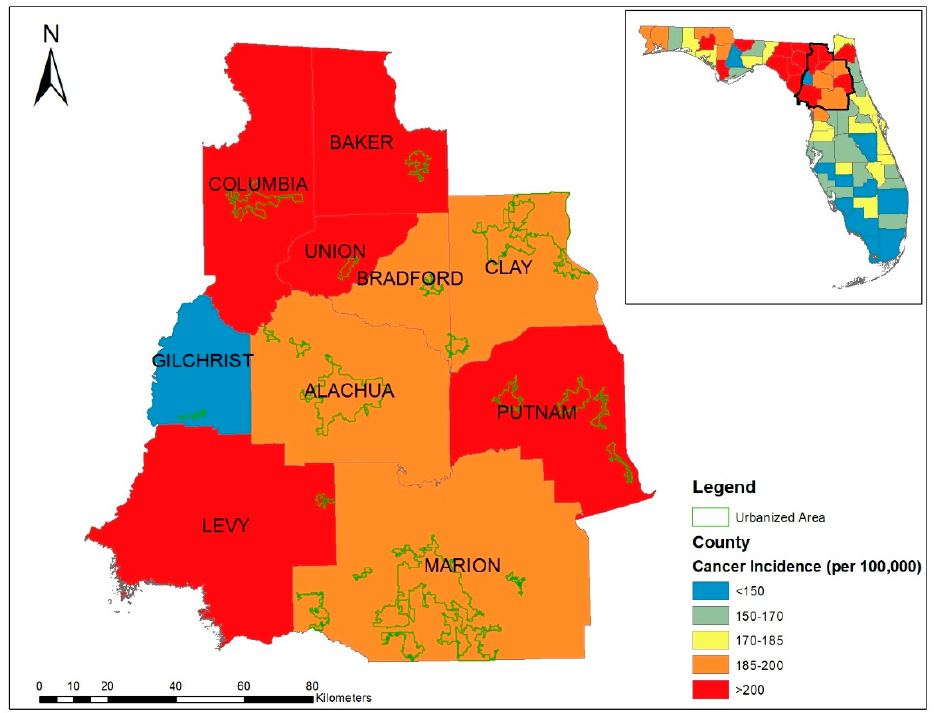
Figure 1. Age adjusted cancer incidence rates (at all cancer sites) for 10 counties in north Florida during 2008, derived from Florida department of Health. The inset map shows the spatial location and scope of study area in Florida.